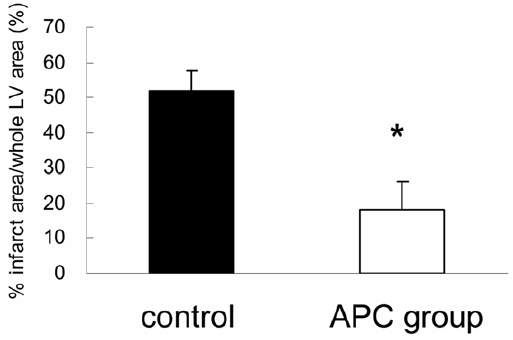
Figure 2. Assessment of myocardial infarct size after regional ischemia/reperfusion injury. We stained slices of left ventricular (LV) tissue with hematoxylin and eosin and Sirius red 2 weeks after inducing transient ischemia. The size of the infarct area was assessed by calculating the percentage of total LV area (% infarction) using Image J. The bar graph shows that the percent infarction in the activated protein C (APC) group was significantly smaller than the controls (* p , 0.05; APC versus